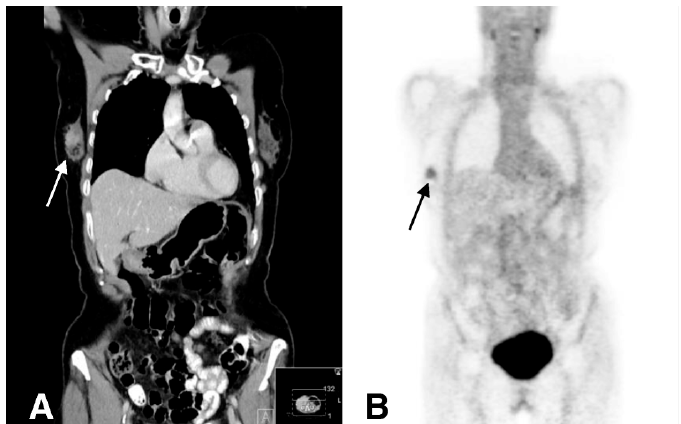
Figure 4. [ 68 Ga]Pentixafor PET scan of a patient with invasive ductal primary breast carcinoma prior to treatment. ( A ) Coronal CT reconstruction shows contrast enhancement in a lesion in the right breast. ( B ) The tumor is visually detectable with [ 68 Ga]Pentixafor. (Figure adapted with permission